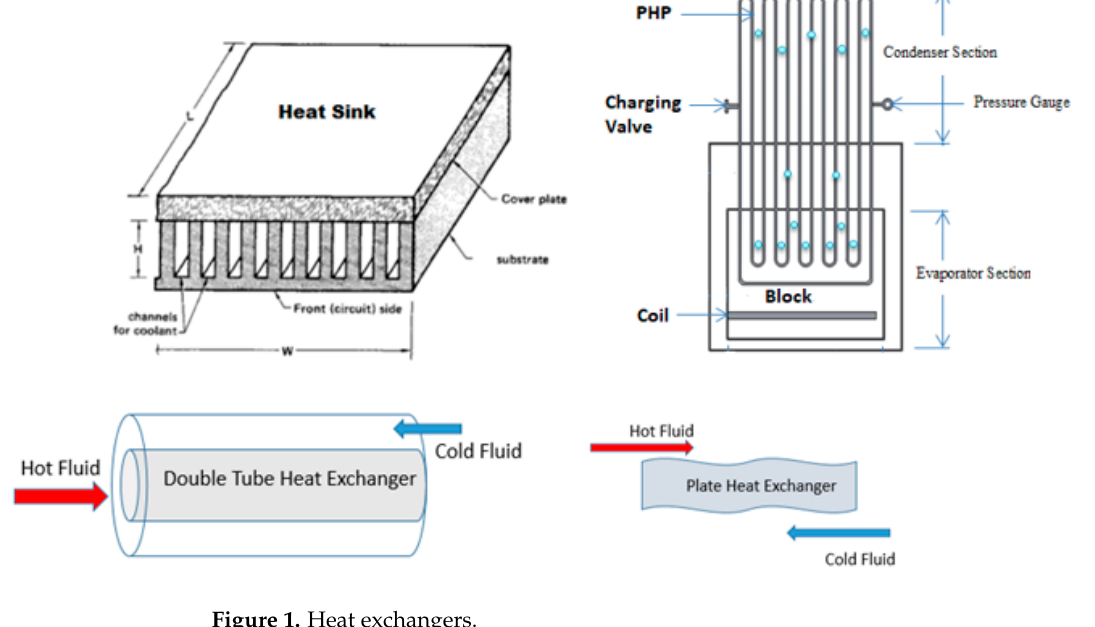
Figure 1. Heat exchangers.